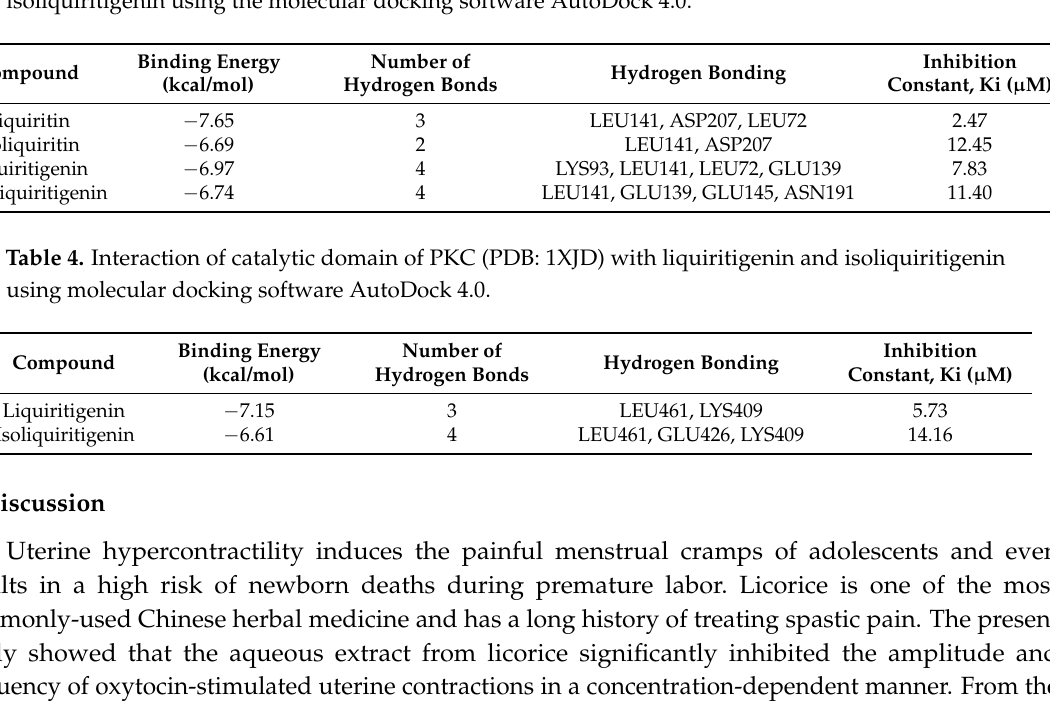
Figure 8. Ligand interaction and comparative binding sites diagrams of ( A ) liquiritigenin and ( B ) isoliquiritigenin in the active site of catalytic domain of PKC. Table 3. Interaction of MK2 protein (PDB: 3R2Y) with liquiritin, isoliquiritin, liquiritigenin and isoliquiritigenin using the molecular docking software AutoDock 4.0.